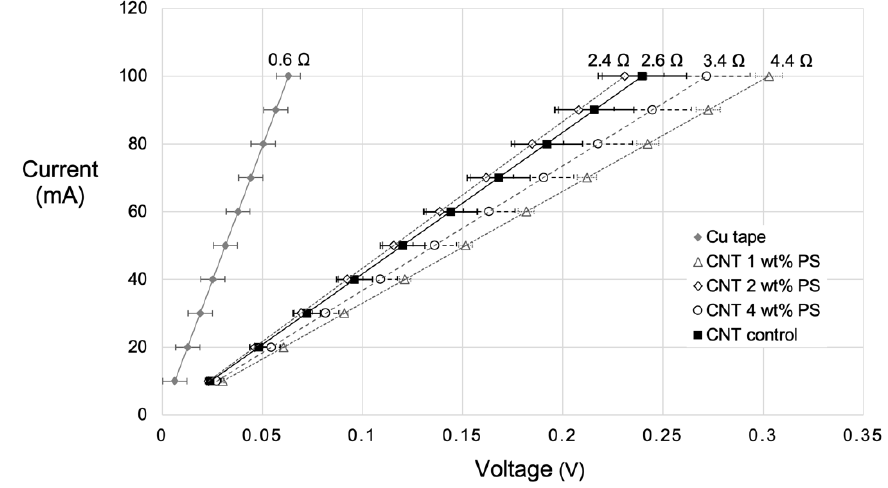
Figure 5. Voltage measurements of acid-washed carbon nanotube samples as compared with com- mercial copper tape.